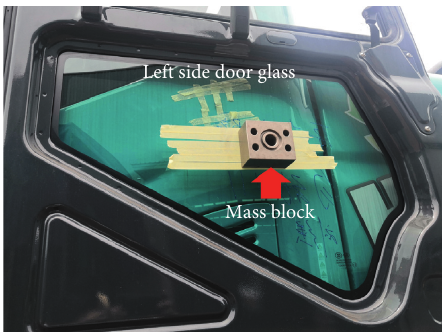
Figure 20: Manual verification on the left side door